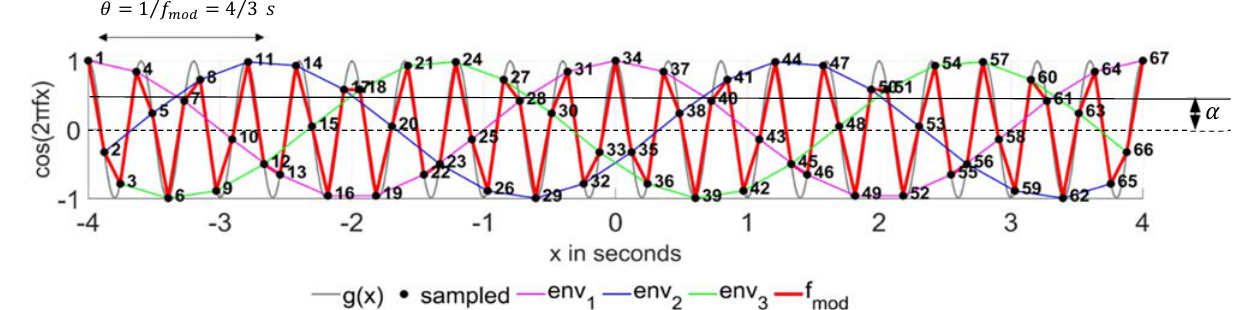
Figure 2. Example of sub-Nyquist artifacts. The original signal g ( x ) (grey line) and its sampled version g ( x k ) (because n = 3) is denoted by the numbered black dots; the n = 3 interlaced modulating envelopes of low frequency ε = 1/4 Hz are shown in magenta, blue and green lines. Successive sample points jump alternately onto the three different envelopes. The sub-Nyquist artefact is the modulated signal of frequency f mod = 3/4 Hz created by the three interlaced